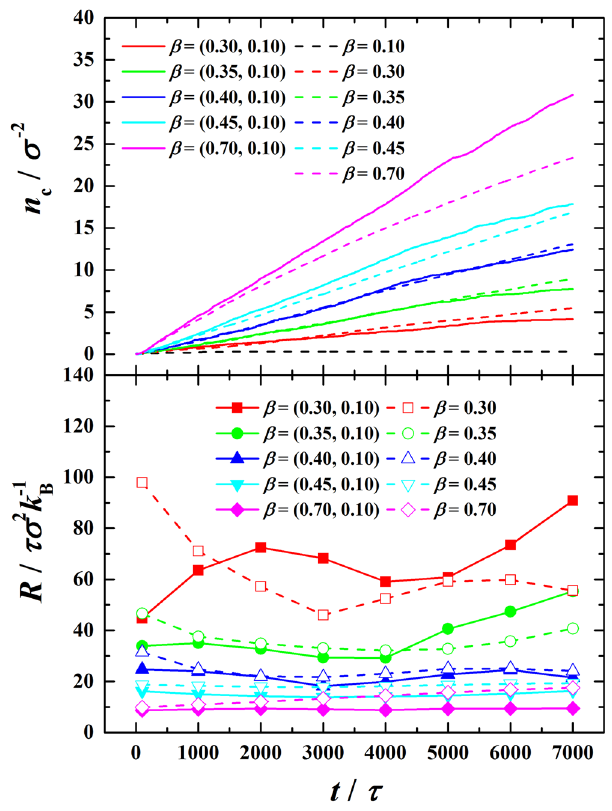
Figure 4. Number of condensed molecules per unit condensing surface area ( n time ( t ) in the condensation